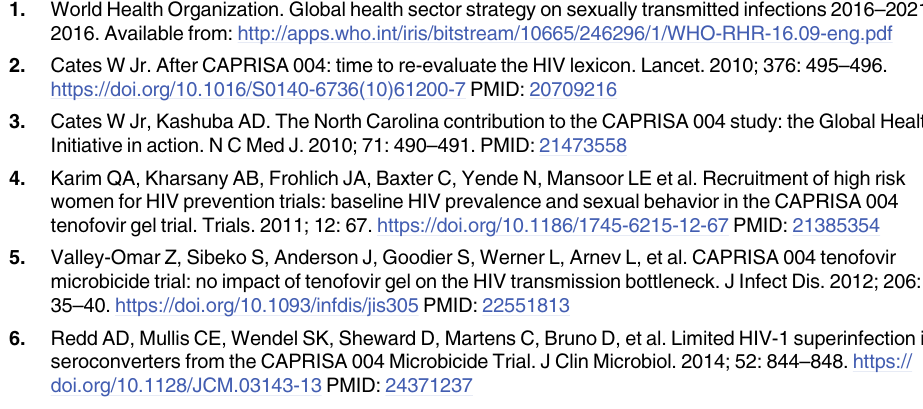
S1 Table. Binding studies realized to validate the used fluorimetric assay.